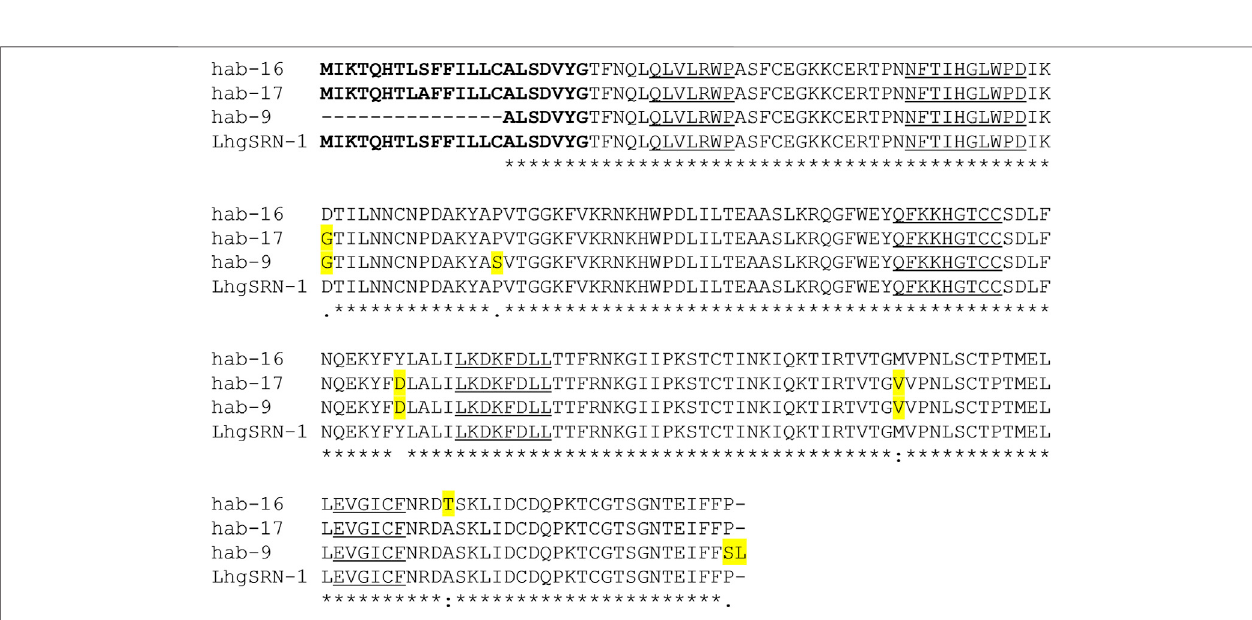
FIGURE7| Aminoacidsequencealignmentof S.habrochaites SI-associatedLhgSRN-1-likehab-16,hab17andhab-9S-RNaseswithSC-associatedLhgSRN-1 S-RNase. Predicted amino acids of LhgSRN-1 S-RNase from SC-2 group accessions are aligned with predicted hab-16 sequences (GenBank OK091165) from SI individualsfromSIaccessionLA2868,hab-17(GenBankOK091166)frommixedSI/SCLA2099(identicalsequenceswererecoveredfromSIEC7andEC10collections aswellasmixedSI/SCaccessionLA1391,notshown)andhab-9inLA0094,GenBankMW183816(identicalsequenceswererecoveredfromaccessionLA1648). The LhgSRN-1-like hab-4 sequence is not shown due to its relatively short length. The predicted signal peptide is bolded, amino acid substitutions are highlighted in yellow and conserved sequences C1-C5 are underlined. Asterisks indicate conservation between all sequences.